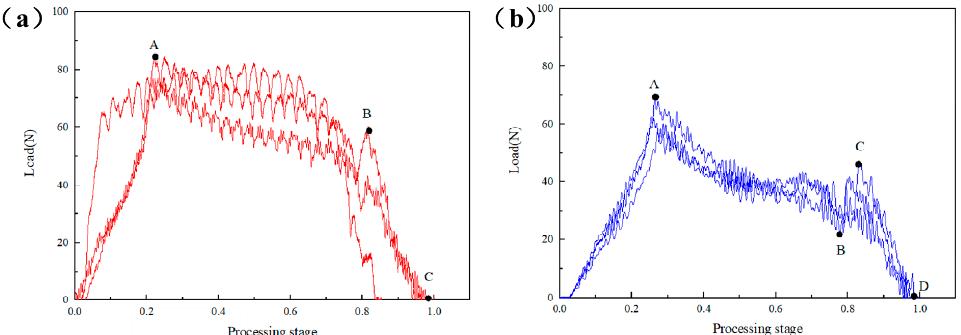
Figure 4. Axial force time curves of constant and dynamic feed speeds with rotation speed of 4000 r/min: ( a ) Constant feed speed 10 mm/min, ( b ) Dynamic feed speed 5–10 mm/min.